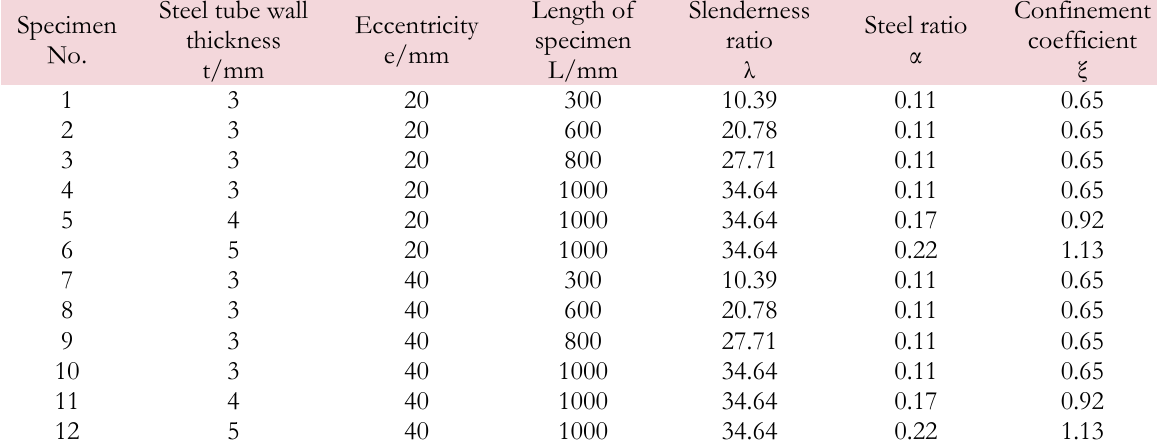
Table 4: Parameters of the Specimens.